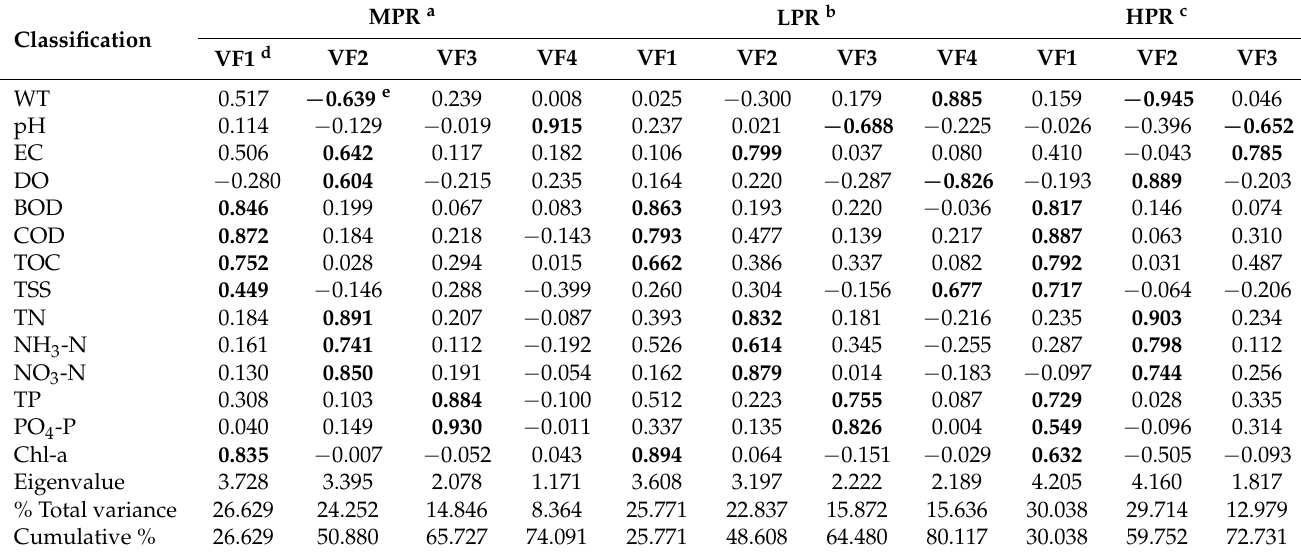
Figure 6. Component plot in rotated space. ( a ) MPR, ( b ) LPR, and ( c ) HPR. Table 1. Loadings of experimental variables (14) on varimax rotates factors matrix of spatial variation in water quality of the Han River Basin, South